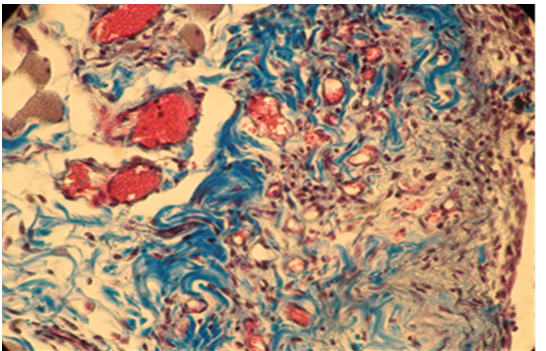
Figure 7. Group B. Moderate inflammation and mild congestive subcutaneous connective tissue in rabbits at 7 days after implantation. Col. Trichrome Masson, ×400 .